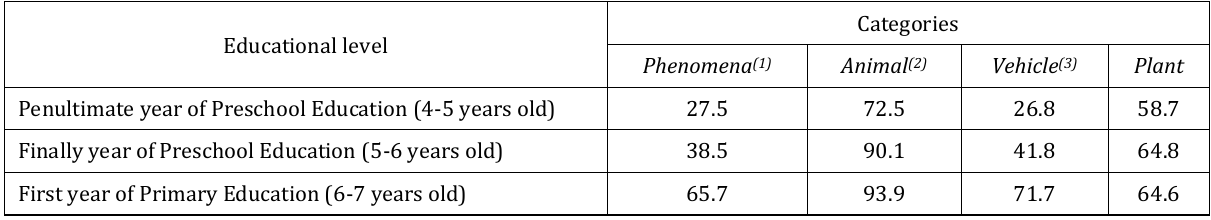
Table 5. The breakdown by educational level of the relative frequency ( % ) of successful completion of each of the four categories considered in the Living/Non-living Distinction